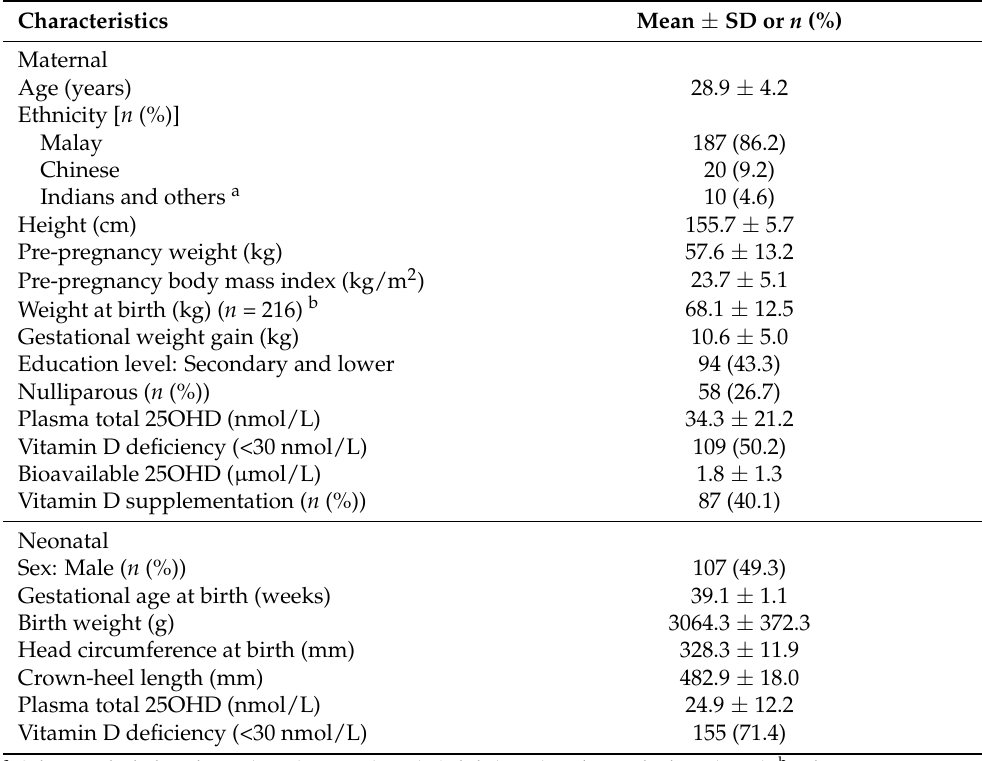
Table 1. Maternal and neonatal characteristics ( n = 217).